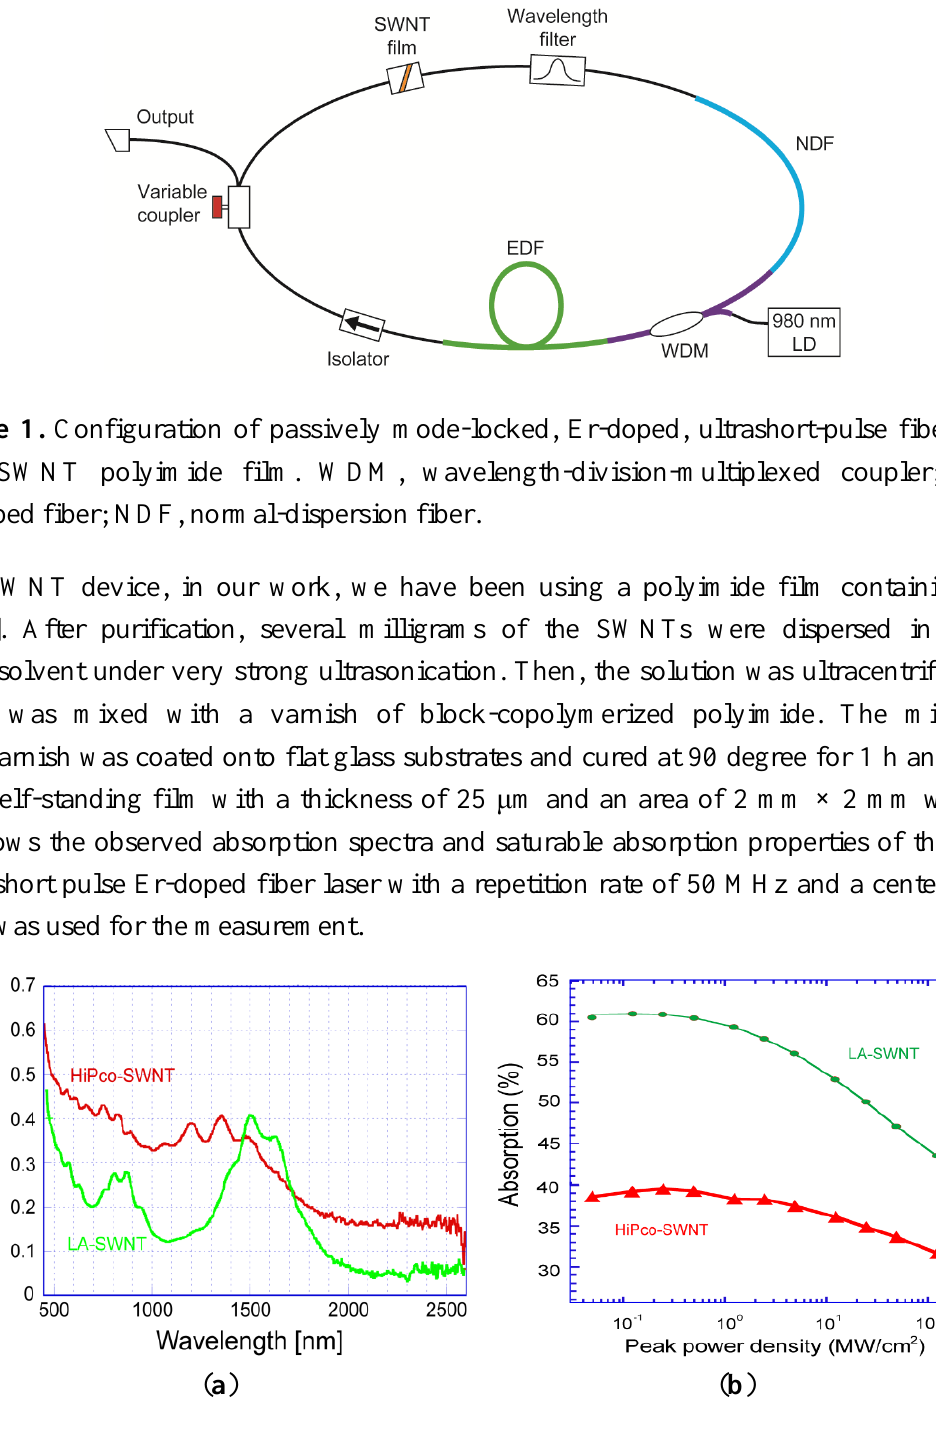
Figure 2. ( a ) Absorption spectra and ( b ) saturable absorption properties of SWNT polyimide film used in this